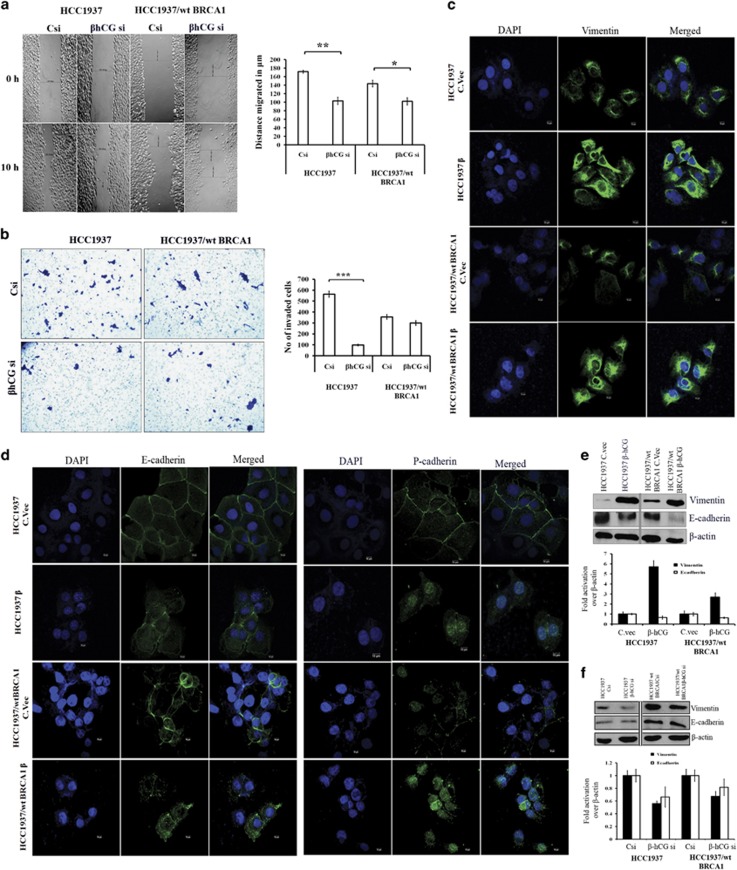
β-hCG induces migration, invasion and EMT. (a) Wound healing assay in HCC1937 and HCC1937/wt BRCA1 upon silencing the endogenous β-hCG expression by transfecting with β-hCG siRNA. “Csi” represents scrambled siRNA and “β-hCG si” represents β-hCG siRNA. Graph represents the distance migrated by cells in μm. (b) Invasion assay in HCC1937 and HCC1937/wt BRCA1 upon silencing the endogenous β-hCG expression. Graph represents the total number of invaded cells. (c) Immunoflourescence of Vimentin in HCC1937 control vector transfected (HCC1937 C.vec), HCC1937 β-hCG transfected (HCC1937 β), HCC1937/wt BRCA1 control vector transfected (HCC1937/wt BRCA1 C.vec) and HCC1937/wt BRCA1 β-hCG transfected (HCC1937/wt BRCA1 β) cells. DAPI was used as nuclear stain. (d) Immunoflourescence of E-cadherin and P-cadherin in HCC1937 C.vec, HCC1937 β, HCC1937/wt BRCA1 C.vec and HCC1937/wt BRCA1 β. (e) Western blot analysis of the Vimentin and E-cadherin upon overexpression of β-hCG in HCC1937 and HCC1937/wt BRCA1 and (f) upon silencing the endogenous β-hCG expression in HCC1937 and HCC1937/wt BRCA1.